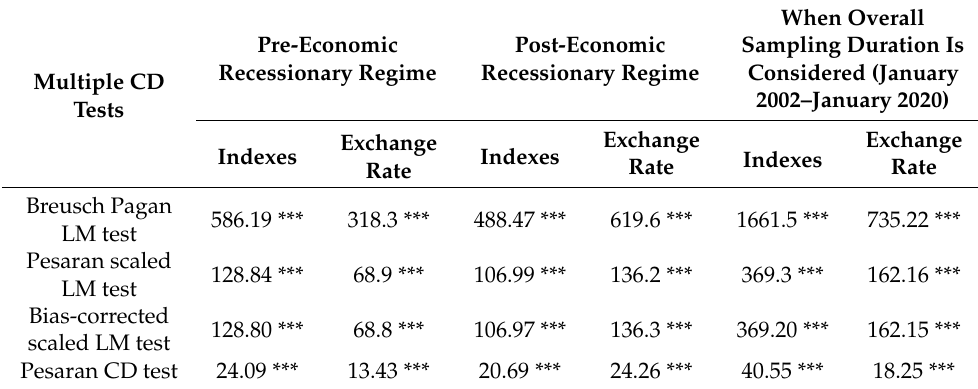
Table 4. Cross-sectional dependence test during the three regimes.